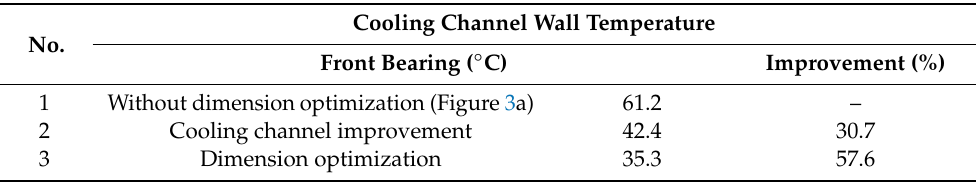
Table 7. Comparison of optimal dimensions of front bearing cooling